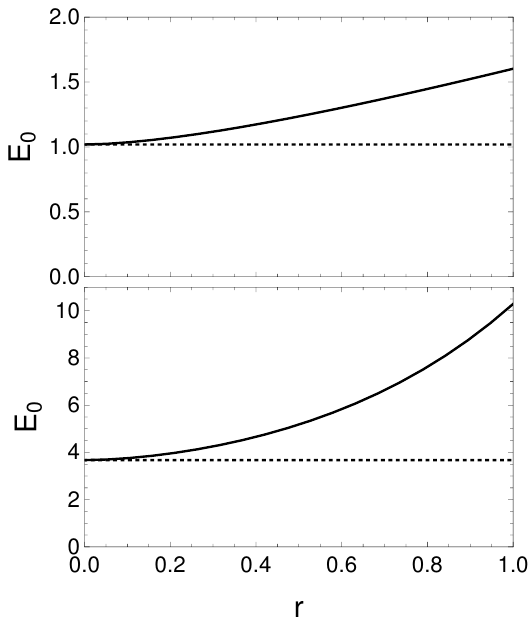
Figure 2 . Dependence of the ground state energy E 0 on the regularization parameter r calculated for the quantum mechanical system with linear potential (2.3) with u = 1 (top) and exponential potential (2.4) with a = 2 and u = 1 (bottom). The dotted lines indicate the results obtained from the analytic solutions for the original ( r → 0 ) potentials (2.1) and